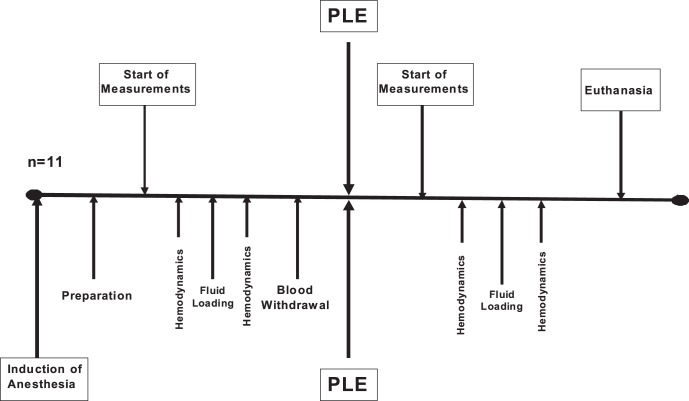
After induction of anesthesia and preparation, measurement of hemodynamics was performed before and after fluid loading.Following blood withdrawal and induction of pleural effusion, hemodynamics before and after fluid loading were determined again.